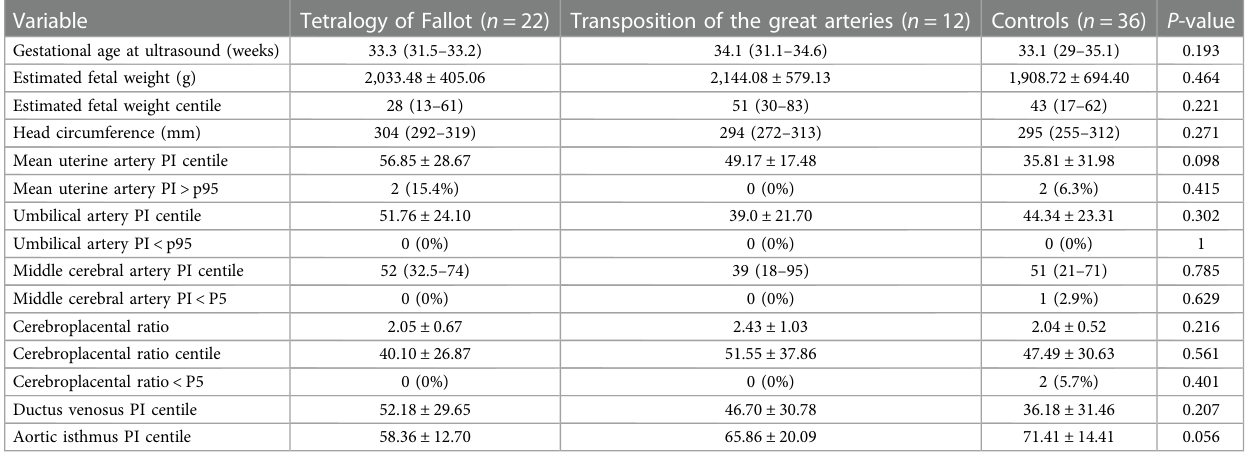
TABLE 2 Feto-placental ultrasound in the study